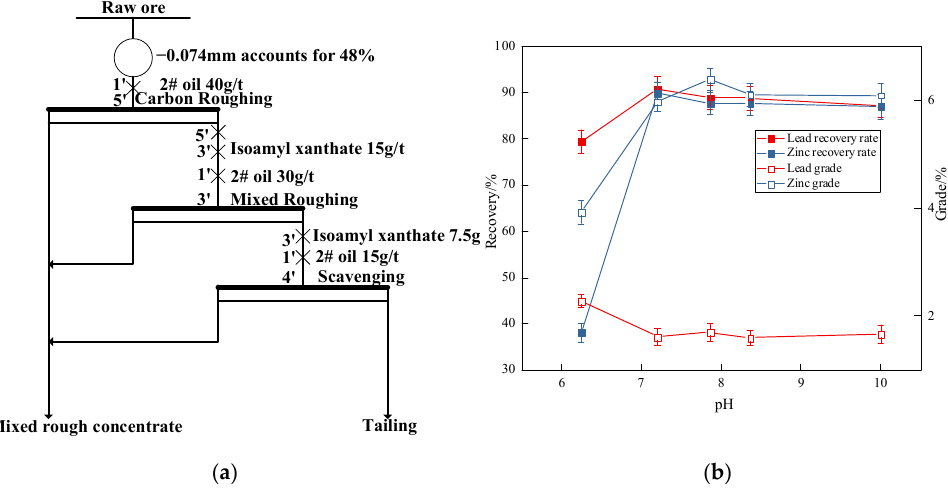
Figure 12. Effect of pH value on the recovery of sulfide aggregates. ( a ) The flow chart for flotation experiments; ( b ) effect of pH value on the flotation recovery.